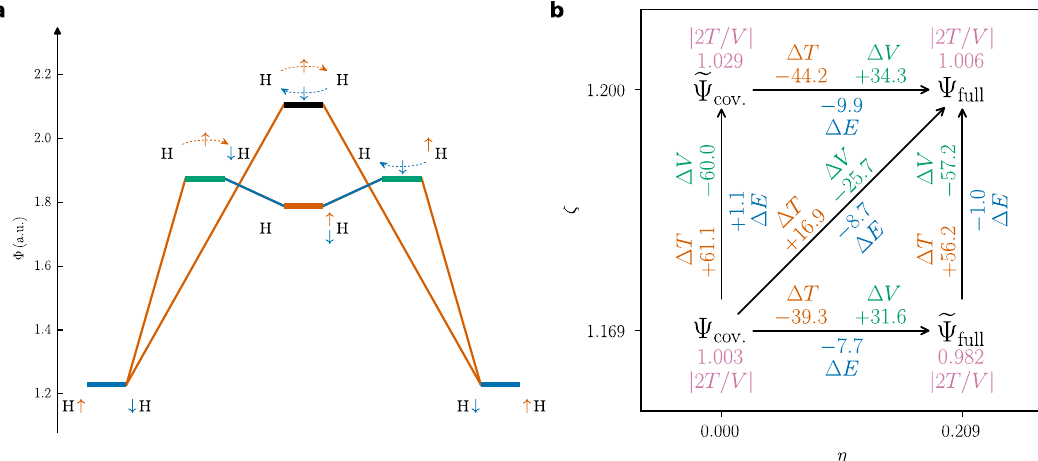
Fig. 3 H 2 at the equilibrium distance. a Probabilistic barriers for the concerted two-electron exchange and for the step-wise exchange with an ionic intermediate SCP. b Step-wise morphing of the covalent Heitler-London wave function Ψ ( η = 0, ζ = 1.169) into the full VB wave function Ψ ( η = 0.209, ζ = 1.200). All energies in m E h